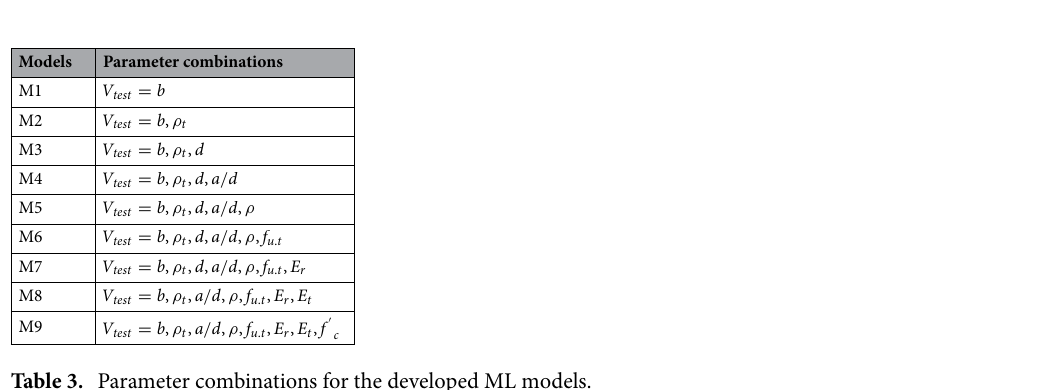
Table 3. Parameter combinations for the developed ML